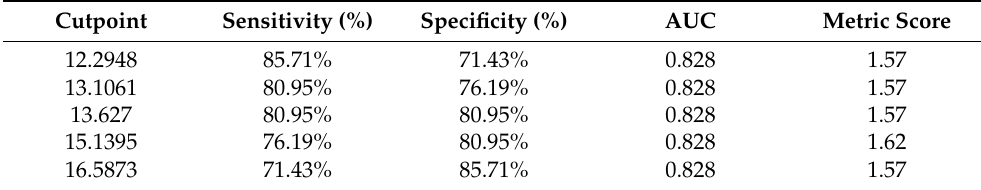
Table 3. The Sensitivity and Specificity cutoff values of the Alveolar crest Angle (ACA) as estimated by the Computer Tool (CT).